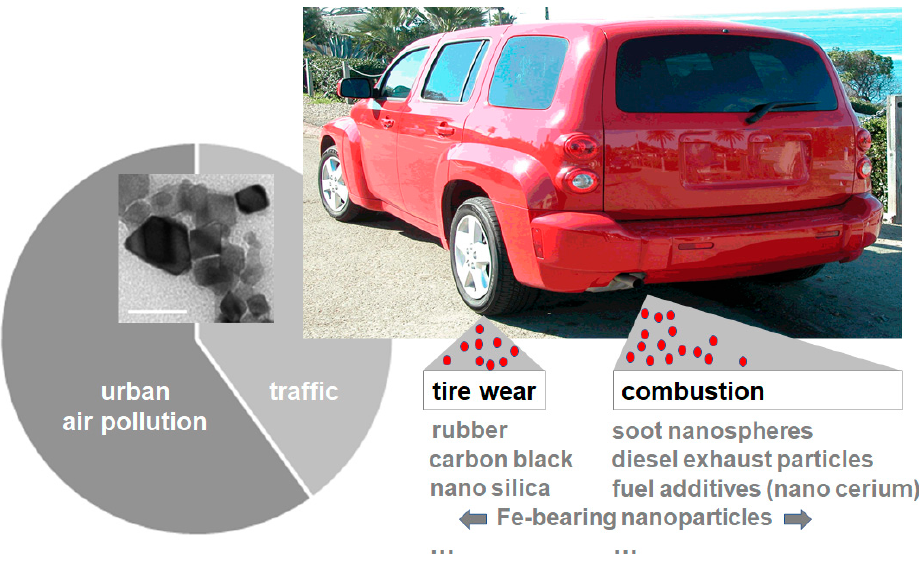
Figure 1. Schematic of particulate matter (PM) emissions. Traffic-related particle emissions constitute a significant proportion of urban air pollution (pie chart). Air pollution nanoparticles (airNPs)